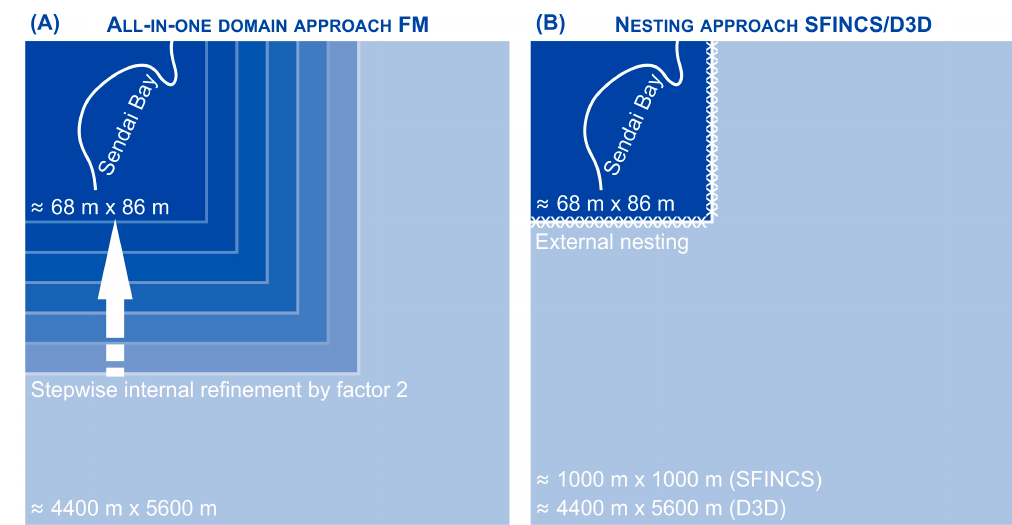
Figure 2. Conceptional diagram showing ( A ) the all-in-one domain approach of the D-FLOW Flexible Mesh (FM) model and ( B ) the nesting approach of the SFINCS/Delft3D-FLOW (D3D) models as well as the spatial resolution of the corresponding computational